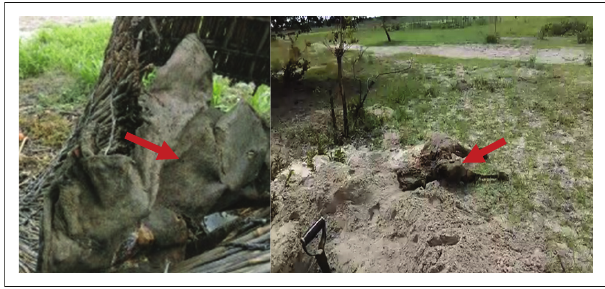
FIGURE 4: Preserved hide from anthrax carcass (left); exhumed remains of incinerated anthrax carcass